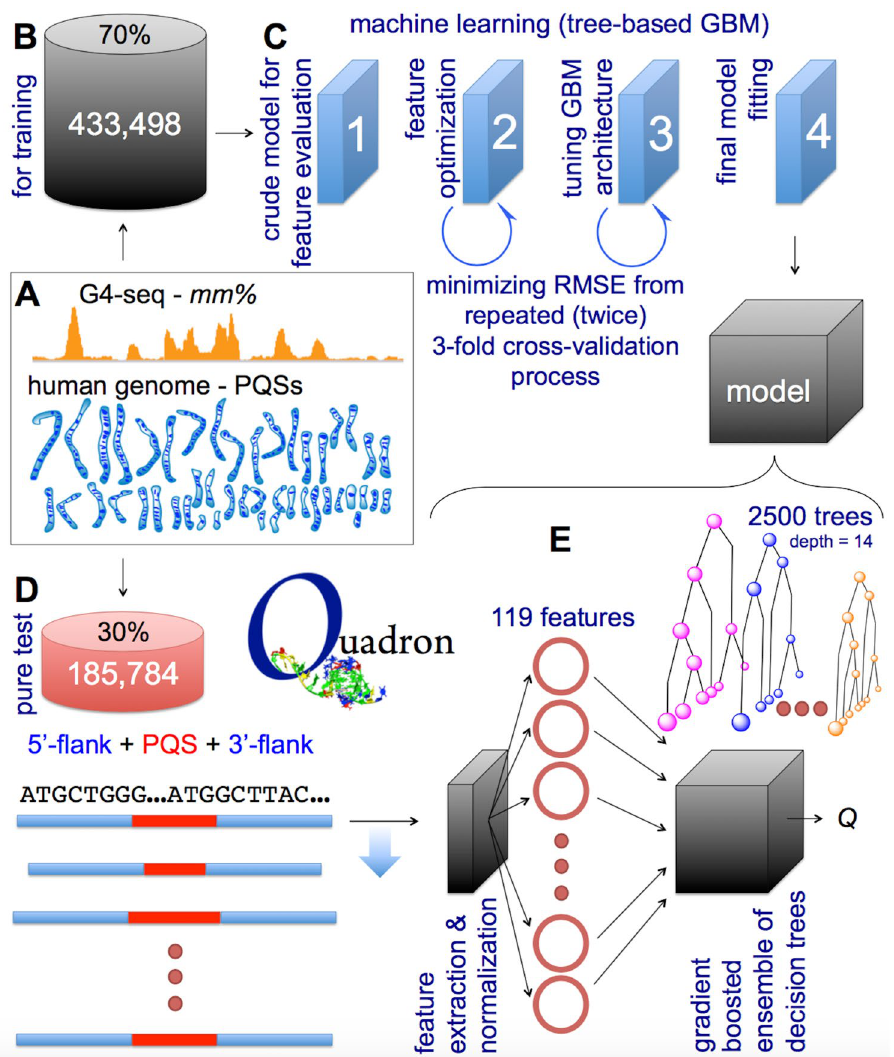
Figure 4. The developed machine learning workflow behind the Quadron model generation. The source data ( A ), its partition used for training cycles ( B ), the major stages of the machine learning procedure ( C ), and the partition of the source data used for model testing ( D ) are schematically shown, along with the structure of the outcome model ( E ), further detailed and referenced in the main